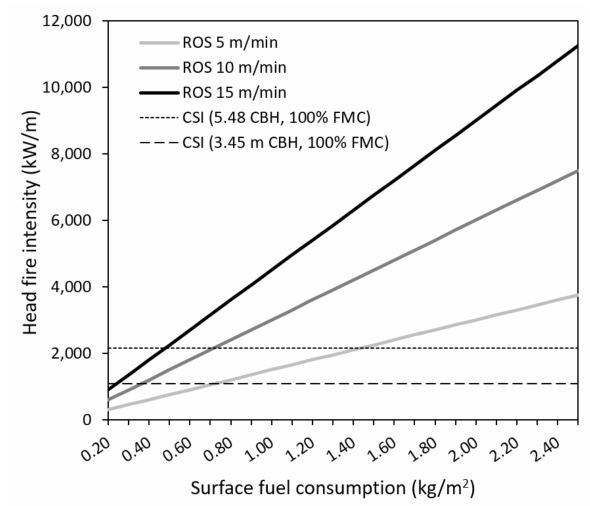
Figure 4. Relationship between Byram’s equation for surface head fire intensity and surface fuel consumption shown for three rates of spread (5, 10, and 15 m / min) in relation to Van Wagner’s critical surface fire intensity (CSI) for the onset of crowning, given mean (3.45 m) and maximum (5.48 m) canopy base heights (CBHs) measured at fuel-treated boreal spruce stands at the Pelican Mountain research site [55] and assuming 100% foliar moisture content